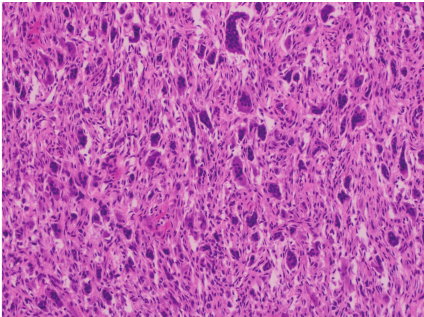
Figure 3: Photomicrograph of the mandibular brown tumor show- ing numerous multinucleated giant cells dispersed in a highly cellular stroma (H&E, magnification × 200).